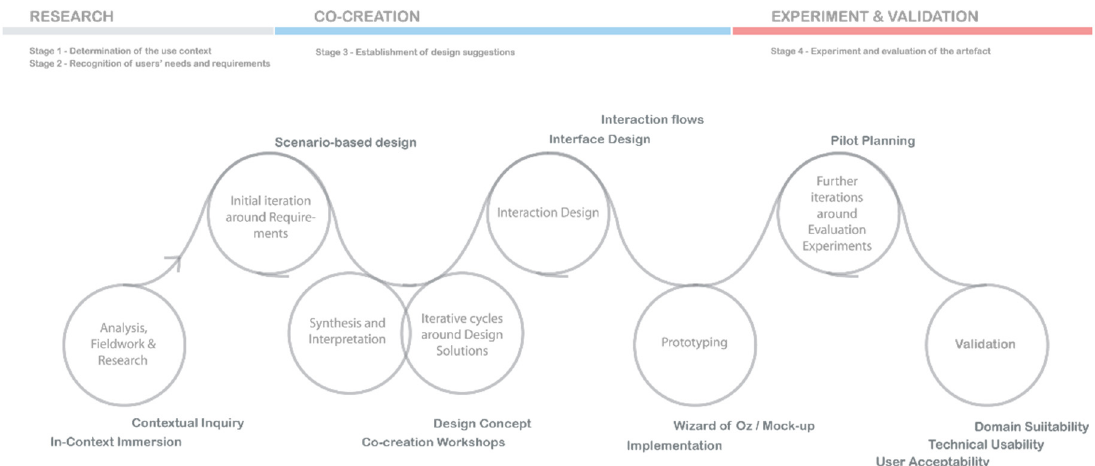
Figure 1. The cooperative, experimental, contextualized and iterative design process highlighting on PD stages and the co-creation activities.